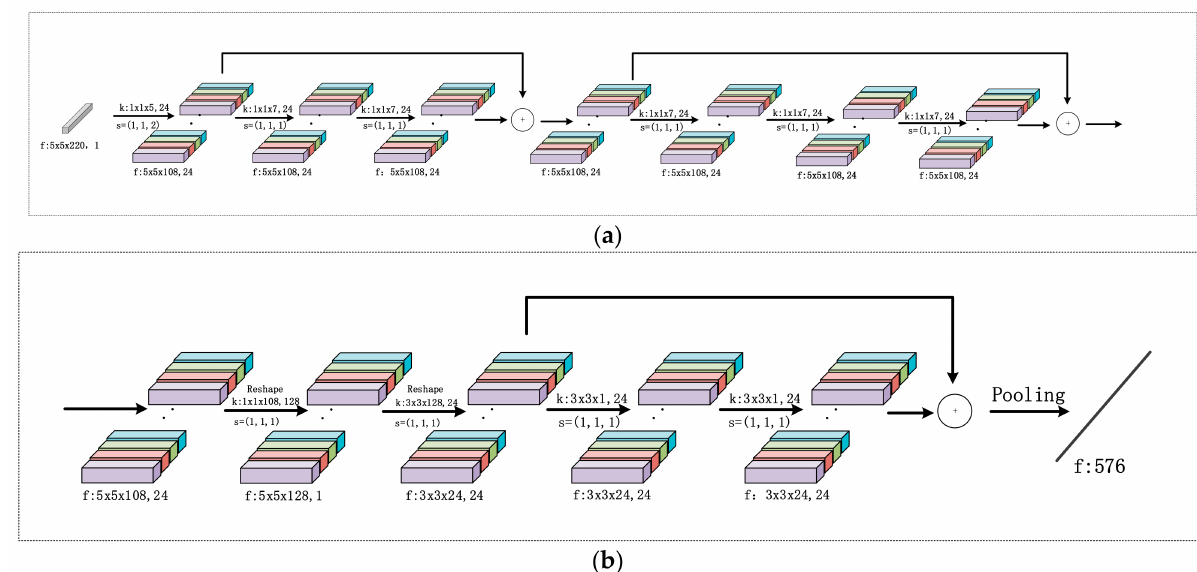
Figure 3. Illustrations of the adopted SSRN architecture for the feature extractor sub-network, together with parameter settings (such as dimension of feature (f), convolution kernels (k) and stride (s)) for all layers and feature maps. ( a ) Spectral residual learning block, ( b ) spatial residual learning block. The two residual learning blocks contain shortcut connections between the two convolutional